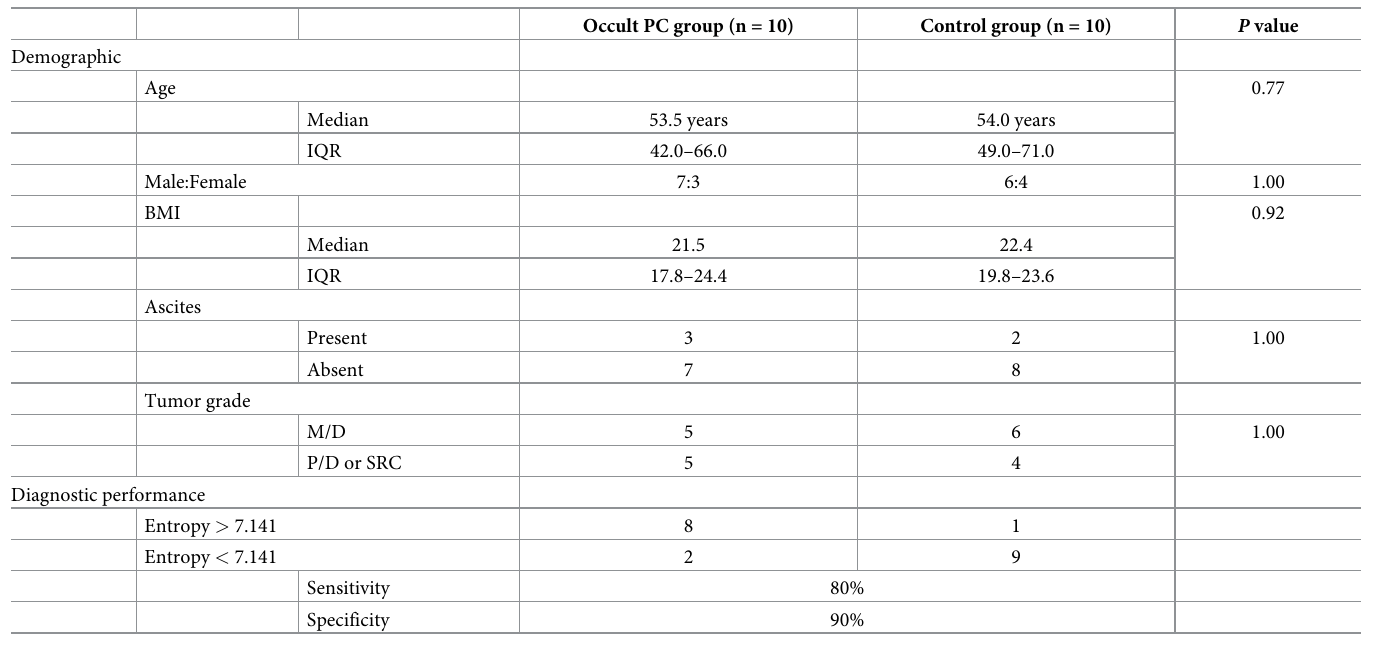
Table 4. Clinical features and diagnostic performance for validation